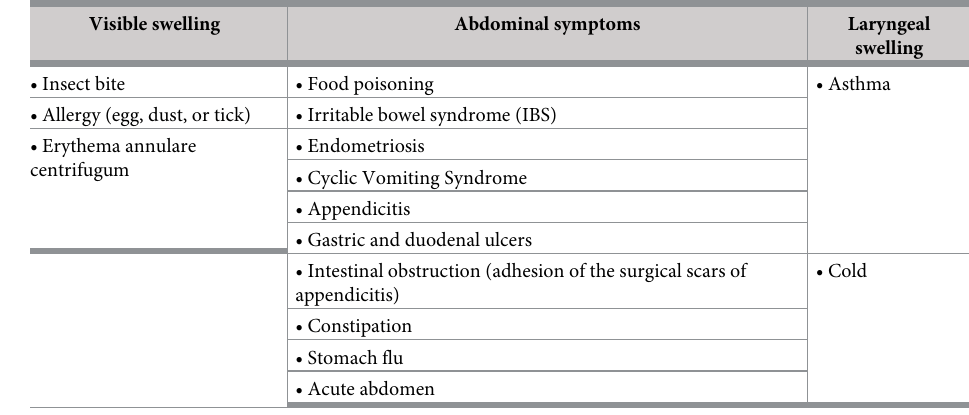
Table 2. Alternative diagnoses in the undiagnosed